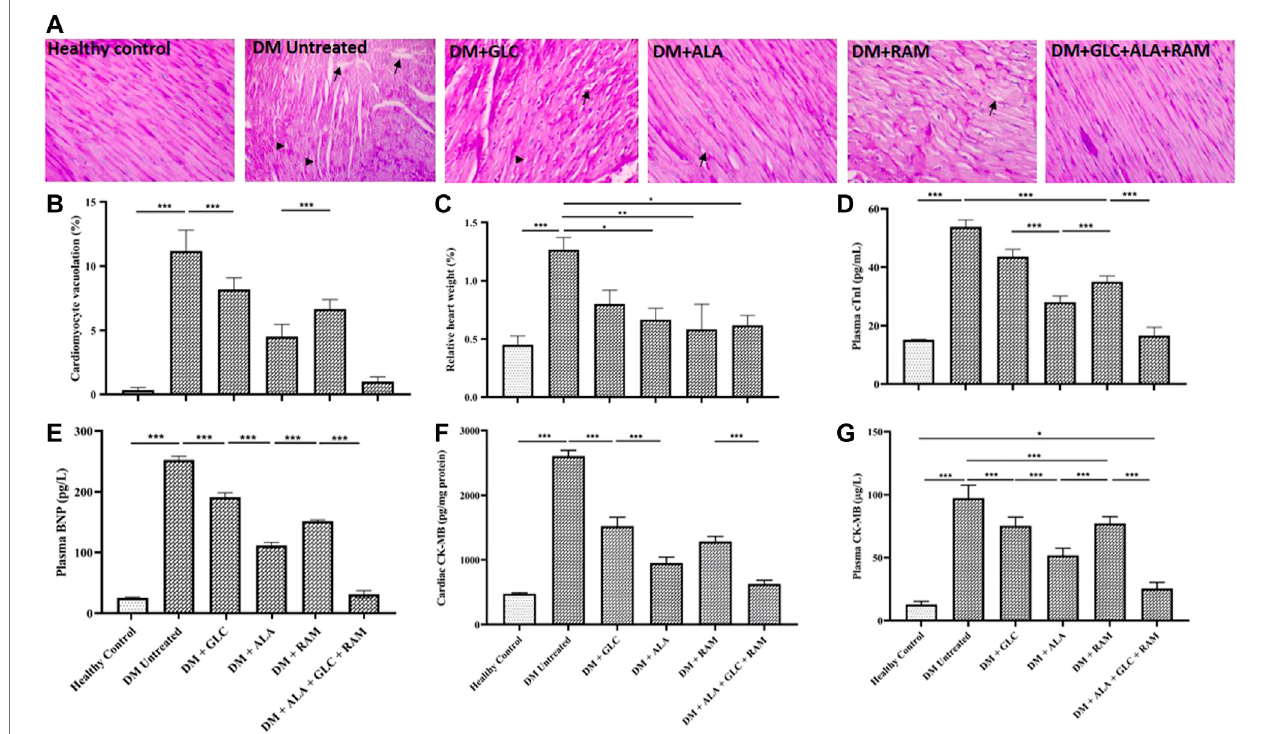
FIGURE 2 | Cardiac histology and damage markers (A) Representative photomicrograph of PAS-stained cardiac tissue from all groups. Arrows indicate cardiomyocytevacuolation and arrow heads indicate myocardial degeneration. ×400magni fi cation in PASstaining. (B) Quanti fi cation ofcardiomyocytevacuolation, (C) relativeheartweight, (D) plasmacardiactroponinI(cTnI), (E) plasmabrainnatriureticpeptide(BNP), (F) cardiaccreatinekinasemyoglobinband(CK-MB)and (G) plasma creatine kinase myoglobin band (CK-MB). Healthy control ( n = 7); DM Untreated = Untreated diabetes mellitus rats ( n = 9); DM + GLC = Diabetic rats treated with gliclazide( n =7);DM+ALA=Diabeticratstreatedwithalpha-lipoicacid( n =7);DM+RAM=Diabeticratstreatedwithramipril( n =7);DM+ALA+GLC+RAM=Diabetic rats treated with alpha-lipoic acid, gliclazide and ramipril ( n = 7). * p < 0.05 vs. diabetic control, ** p < 0.01 vs. diabetic control, *** p < 0.001 vs. diabetic control.